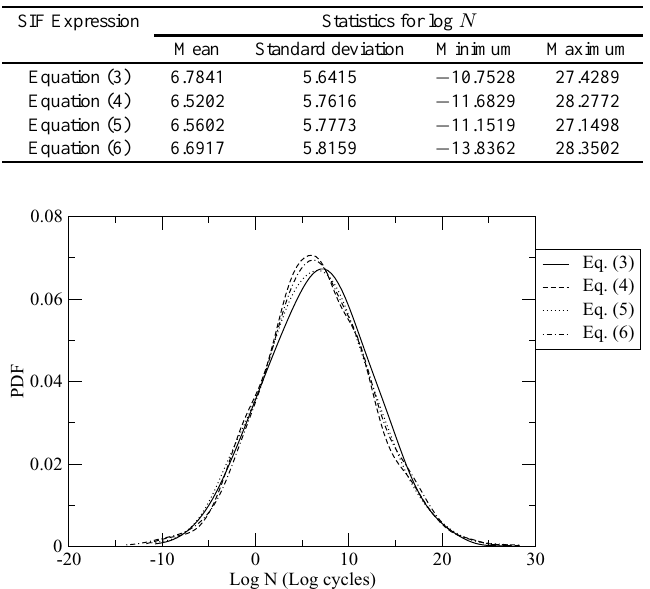
Fig. 4. Probability Density Functions for lifetime for each SIF expression (Eqs (3) to (6)). First Monte Carlo simulation. smoothing was chosen by cross-vaildation as described in [12]. The results are shown in Fig. 4. It is clear from Fig. 4, that all the expressions for the SIF, i.e. different damage propagation laws, lead to